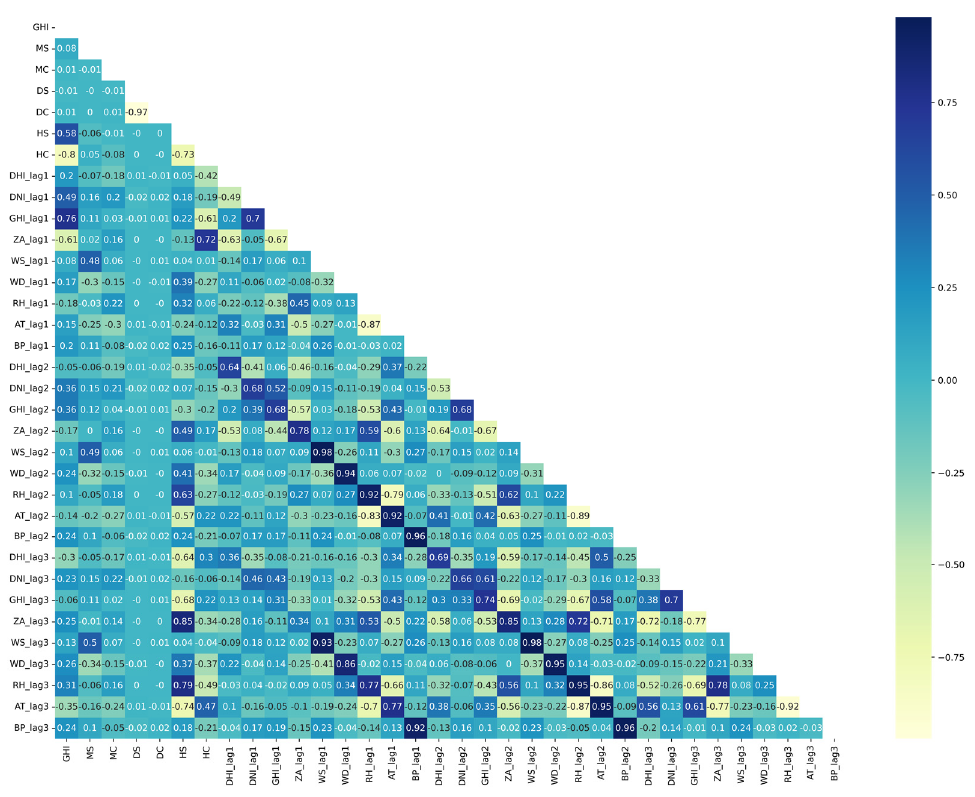
Figure 13. Caracas dataset correlation matrix.